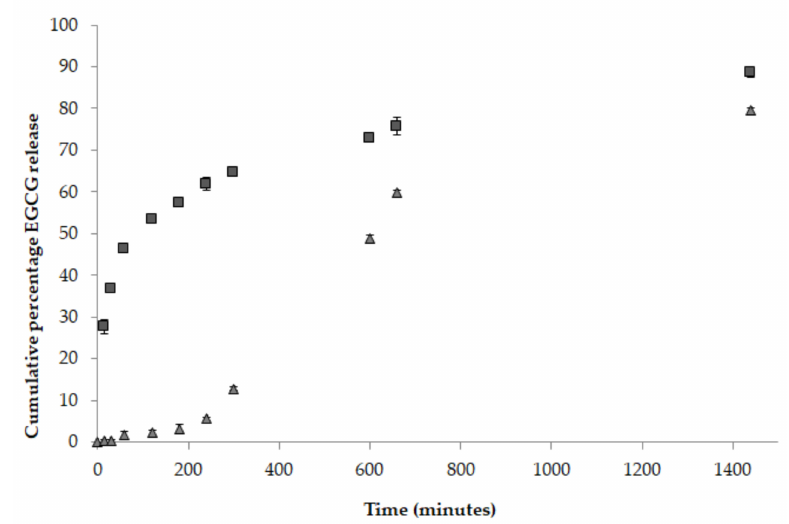
Figure 1. Cumulative percentage of epigallocatechin gallate (EGCG) release from non-coated microspheres (Ch-PP60 8:1 , (cid:4) ) and Eudragit S-100 coated microspheres (S100Ch-PP60, (cid:78) ) in simulated gastrointestinal conditions. Error bars ± standard deviation (SD); n = 3.